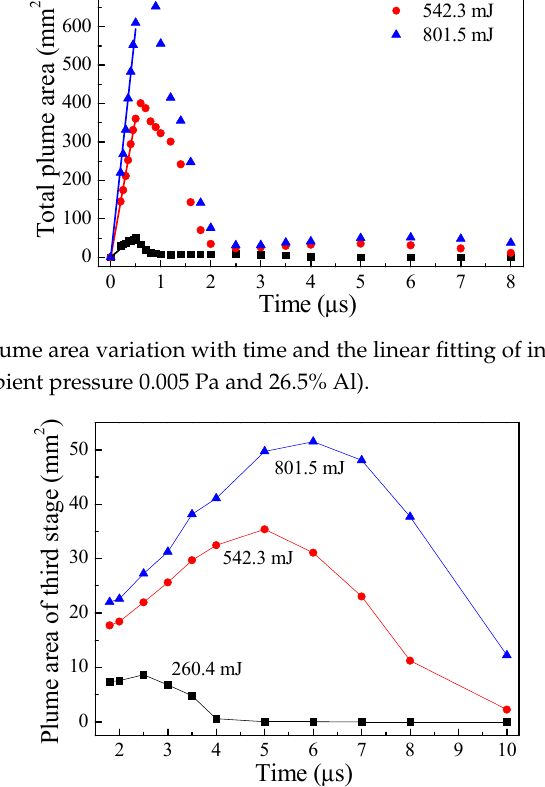
Figure 17. The plume area of third stage variation with time at different laser energies (ambient pressure 0.005 Pa and 26.5% Al).